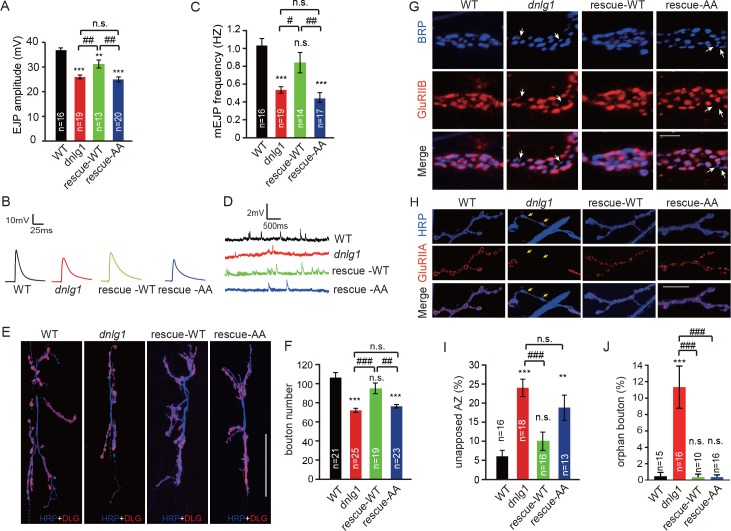
The interaction between DNlg1 and the WRC is critical for the functions of DNlg1 in bouton growth, synaptic transmission, and GluR recruitment.(A–D) Electrophysiological analysis of control and dnlg1 mutant NMJs on muscles 6/7 of third instar larvae indicated that postsynaptic expression of WT DNlg1, but not mutant DNlg1SF-AA, rescued the reduced synaptic transmission in the dnlg1 mutants. (A) Bar graphs of the mean EJP (in mV) and (B) representative traces of the EJP amplitudes in WT, dnlg1 mutant (dnlg1ex1.9/ex2.3), rescue-WT (Mef2-Gal4/+; dnlg1ex1.9/dnlg1ex2.3, UAS-DNlg1-EGFP), and rescue-AA (Mef2-Gal4/+; dnlg1ex1.9/dnlg1ex2.3, UAS-DNlg1SF-AA-EGFP) NMJs. (C) Bar graphs of the mean mEJP frequency and (D) representative traces of the mEJP frequency in WT, dnlg1 mutant, rescue-WT, and rescue-AA NMJs. (E–F) Postsynaptic expression of WT DNlg1, but not mutant DNlg1SF-AA, could rescue the reduced bouton number in the dnlg1 mutants. (E) Confocal images of WT, dnlg1 mutant, rescue-WT, and rescue-AA third instar larvae NMJ type Ib boutons at muscles 6/7 labeled with DLG (red) and anti-HRP (blue). (F) Quantitative data of bouton numbers in (E). (G) Confocal images of third instar larvae NMJ type Ib boutons at muscle four labeled with GluRIIB (red) and postsynaptic active zone marker Brp (blue) to quantify GluR unaligned with the active zone in the same four lines. (H) Confocal images of third instar larvae NMJ type I boutons at muscle four labeled with GluRIIA (red) and HRP (blue) to quantify orphan boutons in the same four lines. (I and J) Statistical analysis of (I) unopposed active zone and (J) orphan boutons that have a presynaptic (HRP) site but lack postsynaptic GluR localization. The green fluorescence signal indicates the expression of EGFP. White arrow: unopposed GluRIIB and BRP; yellow arrow: orphan boutons completely losing GluRIIA positioning. The data in (A), (C), (F), (I), and (J) are shown as the mean ± SEM; n represents the number of NMJ samples analyzed; asterisks indicate significant differences between the WT and the indicated genotypes. **p<0.01; ***p<0.001; n.s., not significant. Hashes indicate significant differences between genotypes. #p<0.05; ##p<0.01; ###p<0.001; n.s., not significant. Scale bars: (E) 50 μm, (G) 1 μm, (H) 20 μm.10.7554/eLife.30457.020Figure 6—source data 1.Sample size (n), mean, SEM, and one-way ANOVA (and nonparametric) with Tukey's multiple comparisons test are presented for the data in Figures 6A, C, F, I and J.